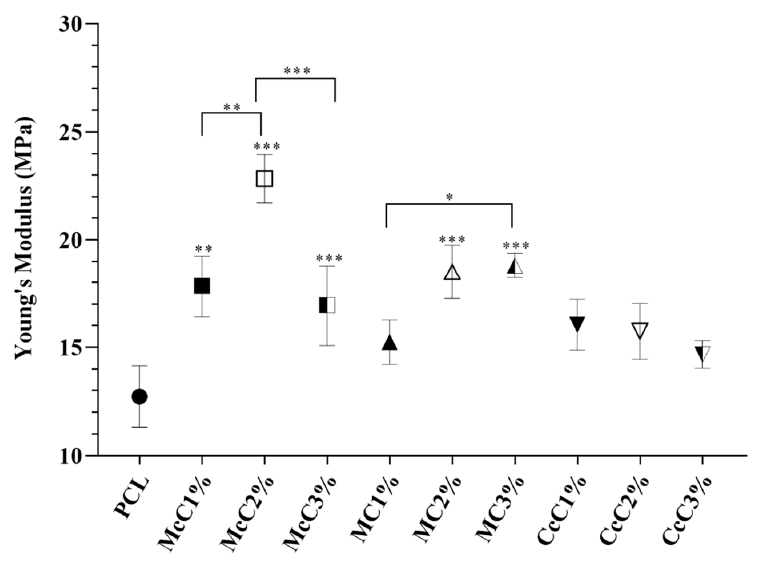
Figure 4. Modulus of tensile strength for filaments obtained by extrusion. (Mean ± SD, n = 3). Significant statistical differences are presented as: * p < 0.05; ** p < 0.01; *** p <